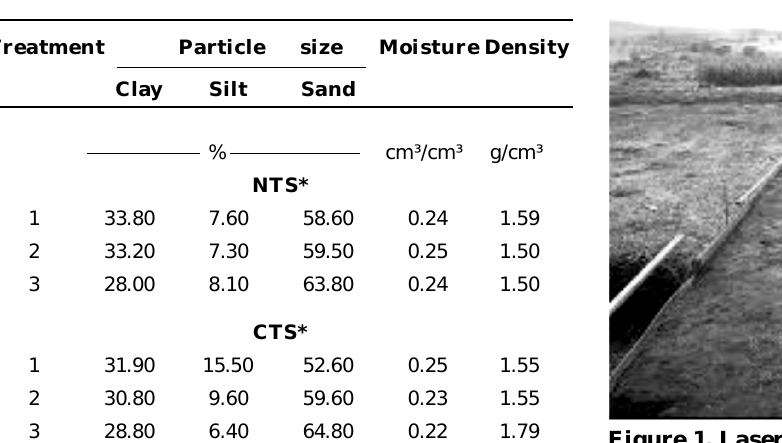
Figure 1. Laser profile scanner installed on one of the experimental plots.